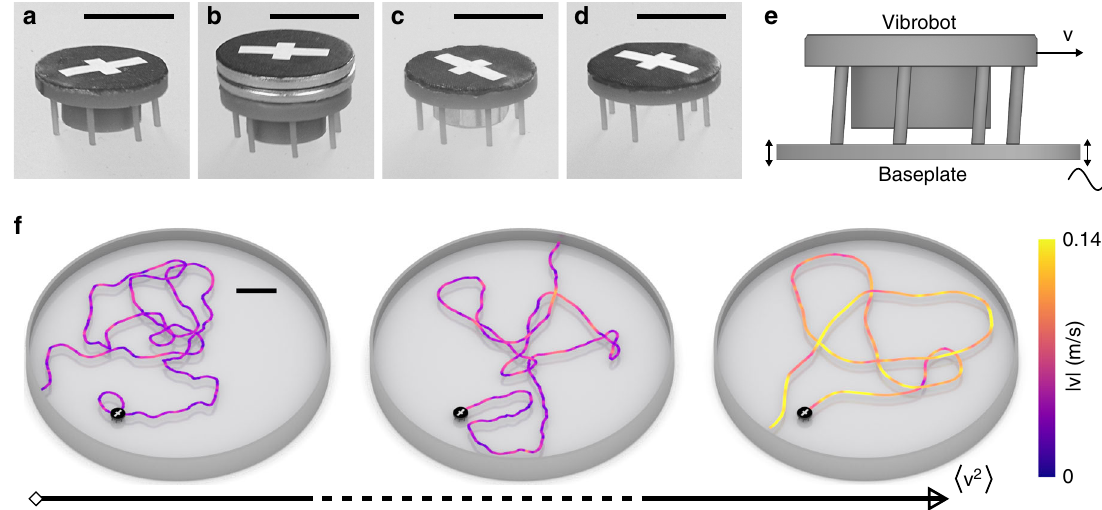
Fig. 1 3D-printed particles, setup and trajectories. a Generic particle. b Carrier particle with an additional outer mass. c Tug particle with an additional central mass. d Ring particle without a central core. Scale bars represent 10 mm. e Illustration of the mechanism with a generic particle on a vibrating plate. f Three exemplary trajectories with increasing average particle velocities. Particle images mark the starting point of each trajectory. The trajectory colour indicates the magnitude of the velocity. Scale bar represents 40